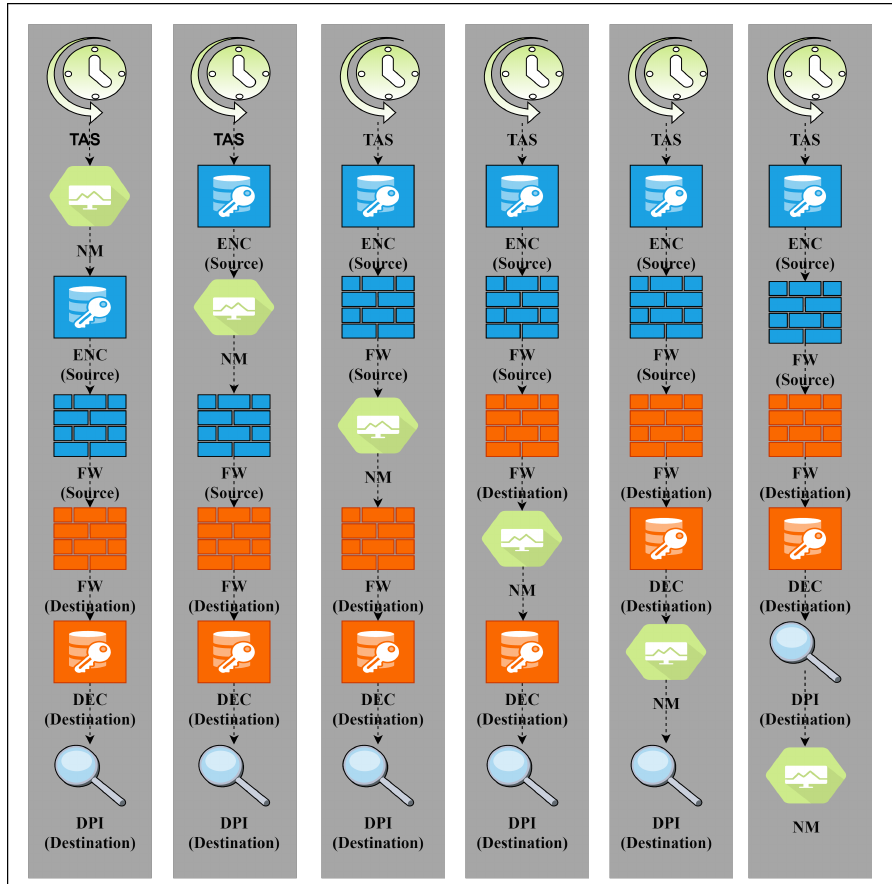
Figure 4. Possible FGs for the general dependency